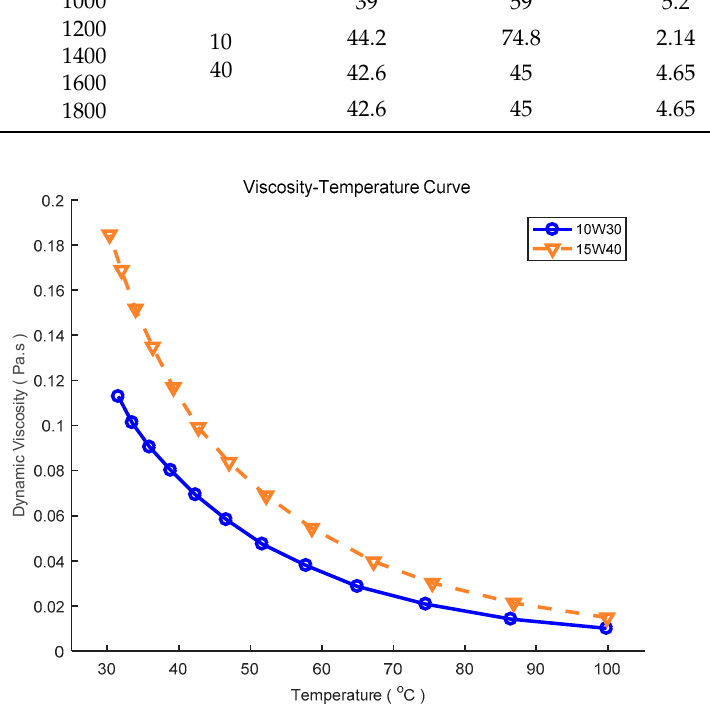
Figure 3. The viscosity–temperature curve of two tested lubricating oils.